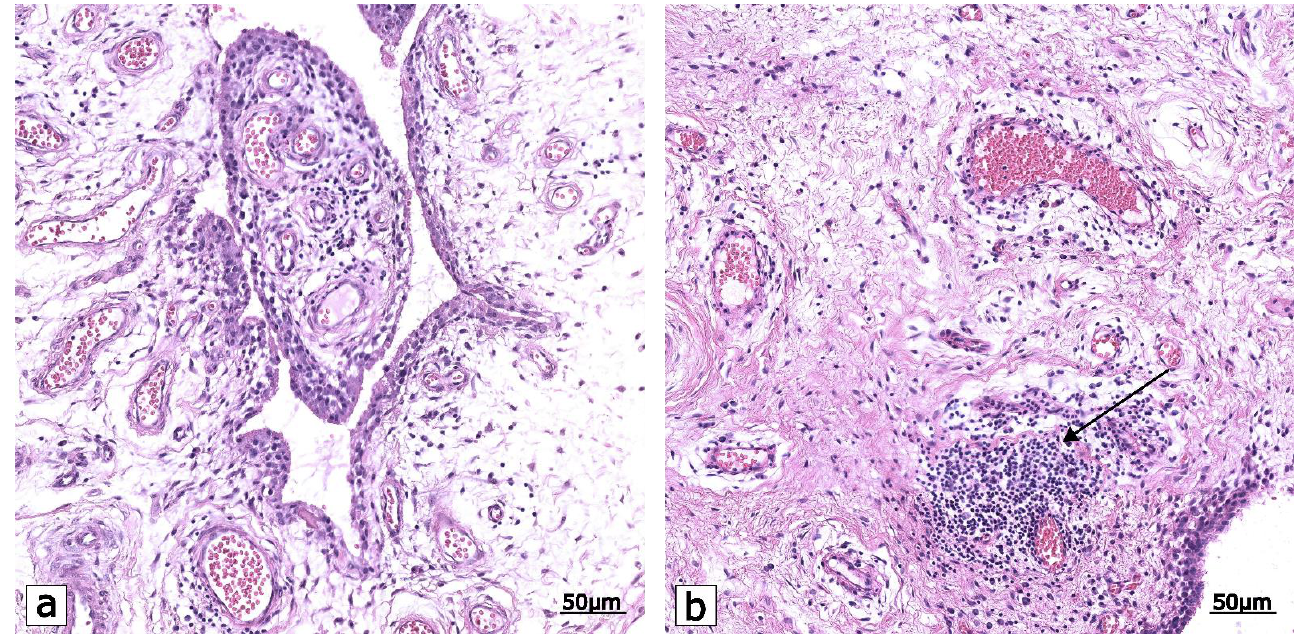
Figure 1. A representative image that depicts the histopathological features of low-grade synovitis in OA. ( a ) The synovial lining layer is slightly thickened, and the stromal density is slightly increased; few perivascular lymphocytes are evident. ( b ) The lining cells form 3 – 4 layers, the cellular density within synovial stroma is increased, and inflammatory infiltrate is present (arrow). Hematoxylin and eosin staining. Scale bars: 50 μm.